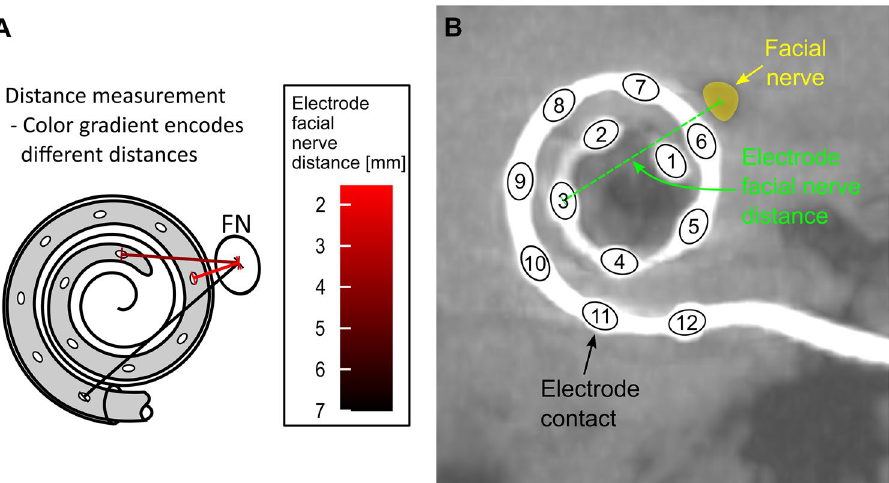
Figure 3. ( A ) Schematic illustration of the measurement of the electrode facial nerve distance with color- coding of the relative distances (red: shortest distance; black: longest distance). ( B ) Example of the measurement of the electrode facial nerve distance in the cochlear view of an fpVCT SECO scan. The electrode contacts of the CI are numbered in order from apical to basal. The facial nerve canal is marked in yellow in the scan. The dashed green line symbolizes the distance between the center of the facial nerve and the electrode contact number